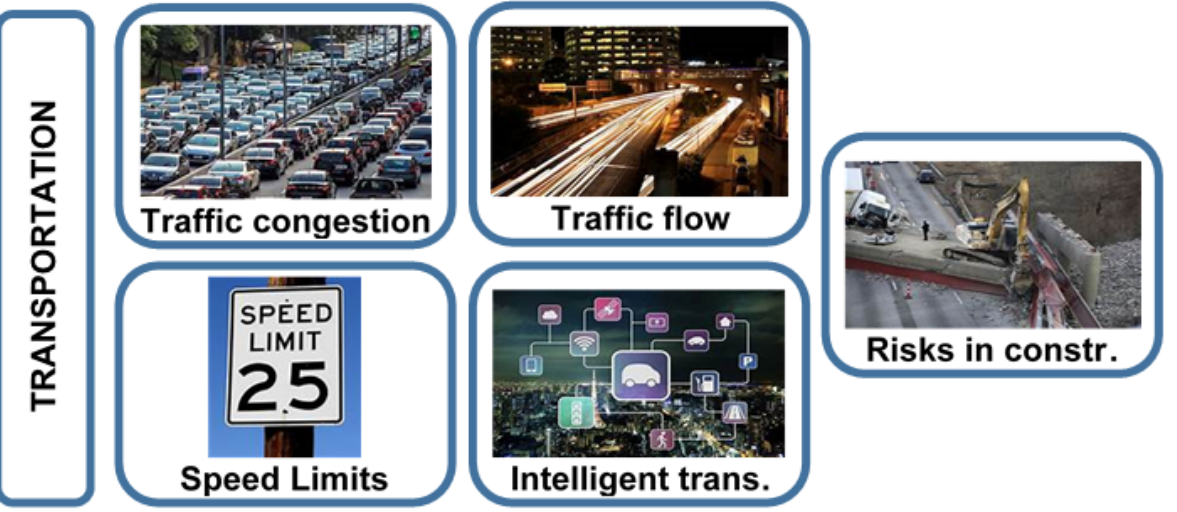
Figure 10. Transportation networks